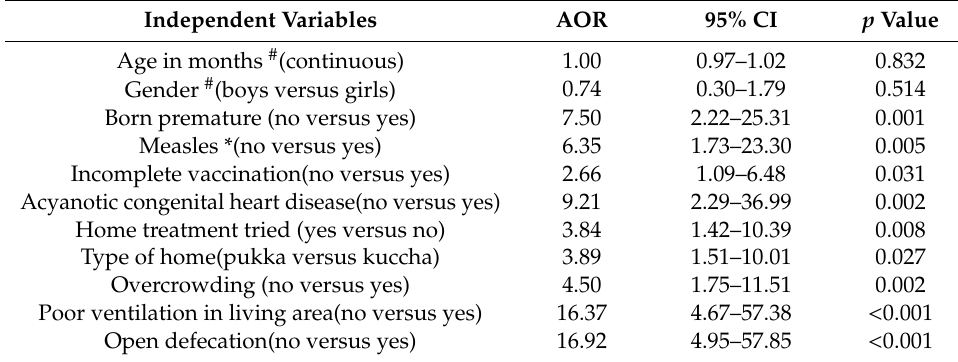
Table 5. Multivariate analyses of socio-demographic, past treatment-related, environmental, and sign- and symptom-related risk factors of severe pneumonia in hospitalized children ( n = 270) in Ujjain, India. Independent Variables AOR 95% CI p Value Age in months # (continuous)